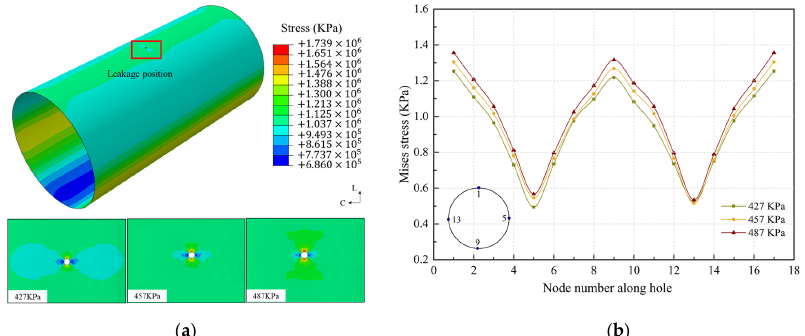
Figure 12. The influence of local damage under various water pressures, where C represents the direction of circumference and L represent the longitudinal direction: ( a ) Von Mises stress distribution; ( b ) Von Mises stress curves.